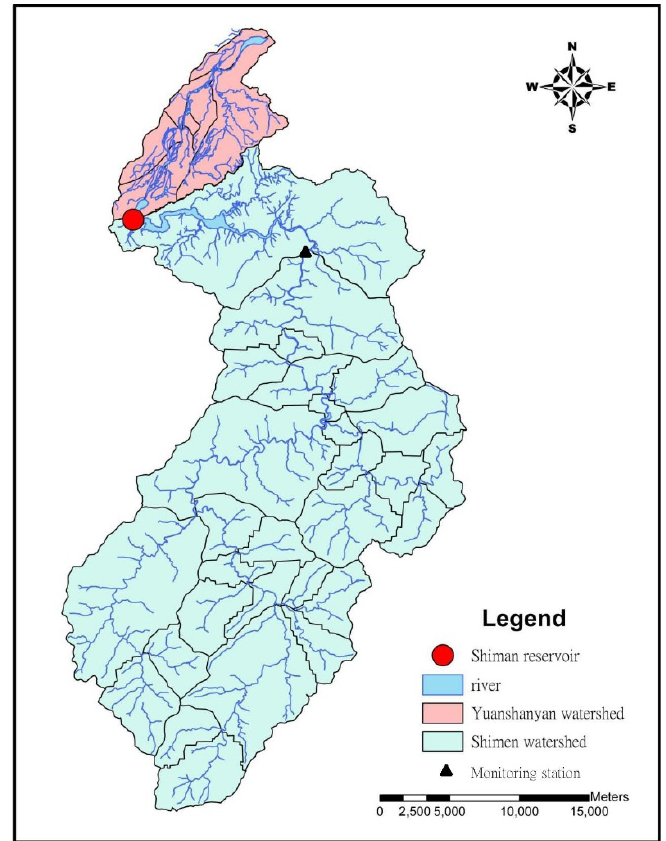
Figure 3. Watershed used for SUSTAIN model calibration and verification; this area is located upstream of the Yuanshanyan watershed and is not influenced by the Shiman Reservoir, which divides this area from the Yuanshanyan